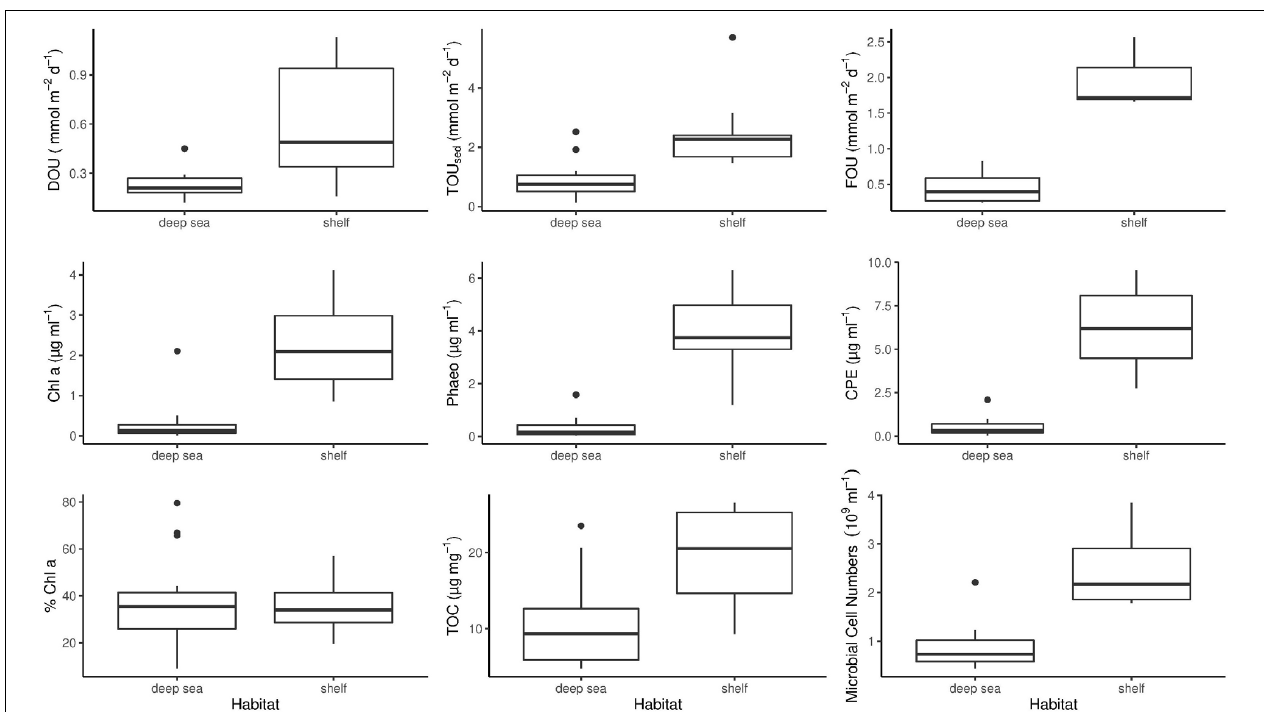
FIGURE 2 | Benthic oxygen uptake and environmental parameters measured during PS94. Differences between shelf and deep-sea habitats are shown. The bottom and top of the box refer to the 25th and 75th percentile, respectively. The centreline constitutes the median and the upper and lower whiskers are calculated as the upper and lower boundary of the box + 1.5 ∗ the interquartile range. Data points outside this range are plotted as outliers. TOU sed , Total oxygen uptake; DOU, Diffusive oxygen uptake; CPE, Chloroplastic pigment equivalent; TOC, Sediment total organic carbon content; Chl a , Sediment chlorophyll a concentration; Phaeo, Sediment phaeopigment concentration; FOU, Fauna mediated oxygen